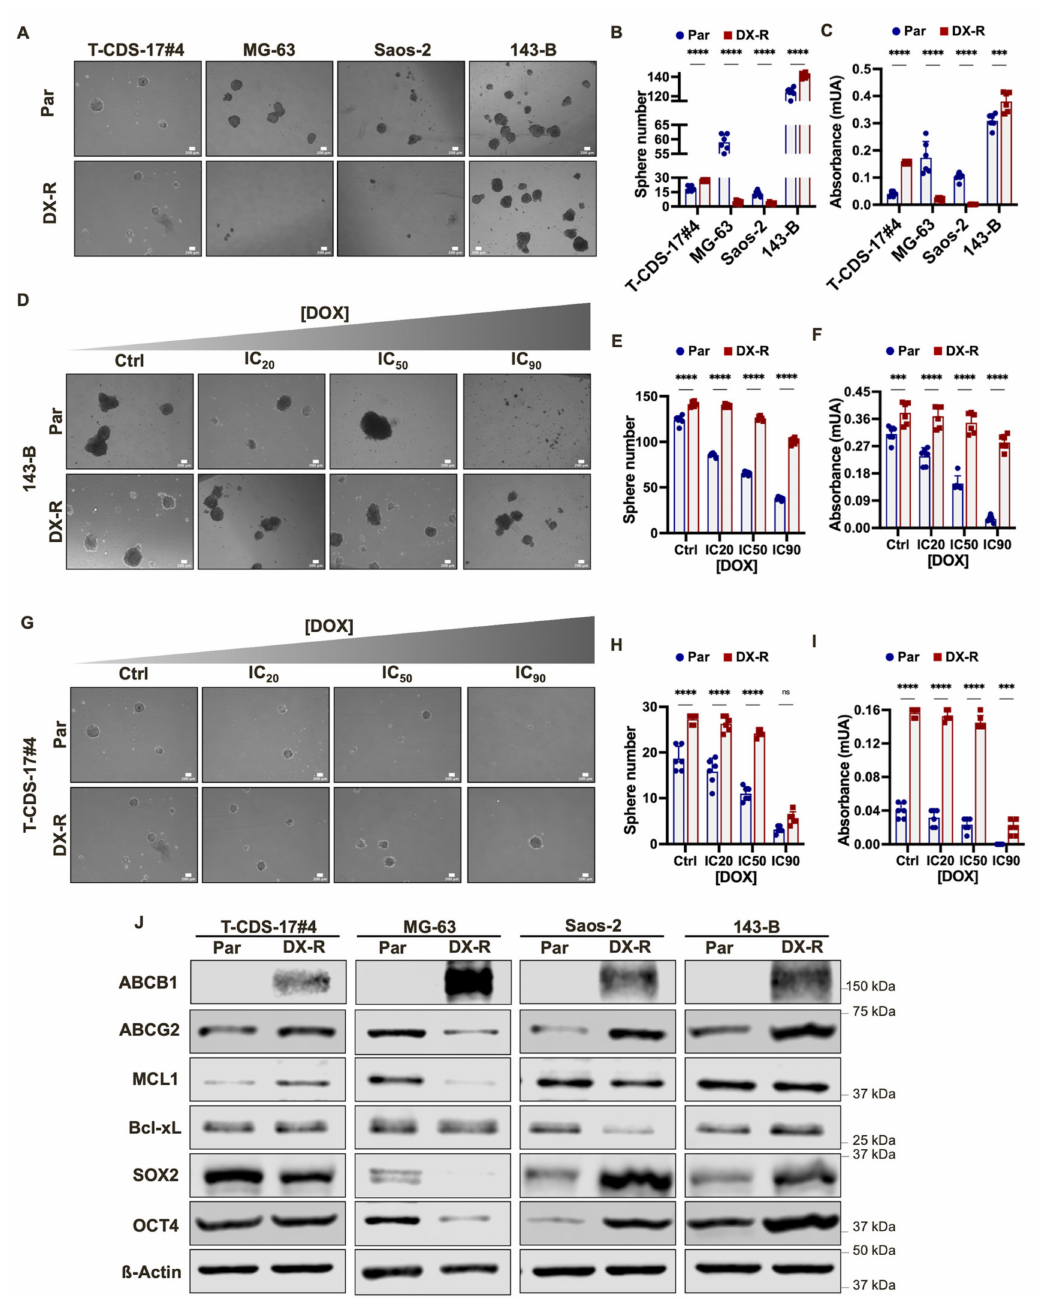
Figure 5. Stemness-related phenotypes in DX-R bone-sarcoma cell lines. ( A – C ) Tumorsphere forma- tion potential of parental and DX-R bone sarcoma cell lines. Representative images of each condition ( A ) and quantification of the number of tumorspheres by direct counting ( B ) and cell viability (WST-1 assays) ( C ) are presented. ( D – I ) Effect of DOX treatment on the viability of tumorsphere cultures of parental and DX-R 143-B ( D – F ) and T-CDS-17#4 cells ( G – I ). Tumorsphere 10-day cultures were treated with IC 20 (10 nM for 143-B and 8 nM for T-CDS-17#4), IC 50 (50 nM for 143-B and 90 nM for T-CDS-17#4) or IC 90 (350 nM for 143-B and 4600 nM for T-CDS-17#4) concentrations of DOX for 96